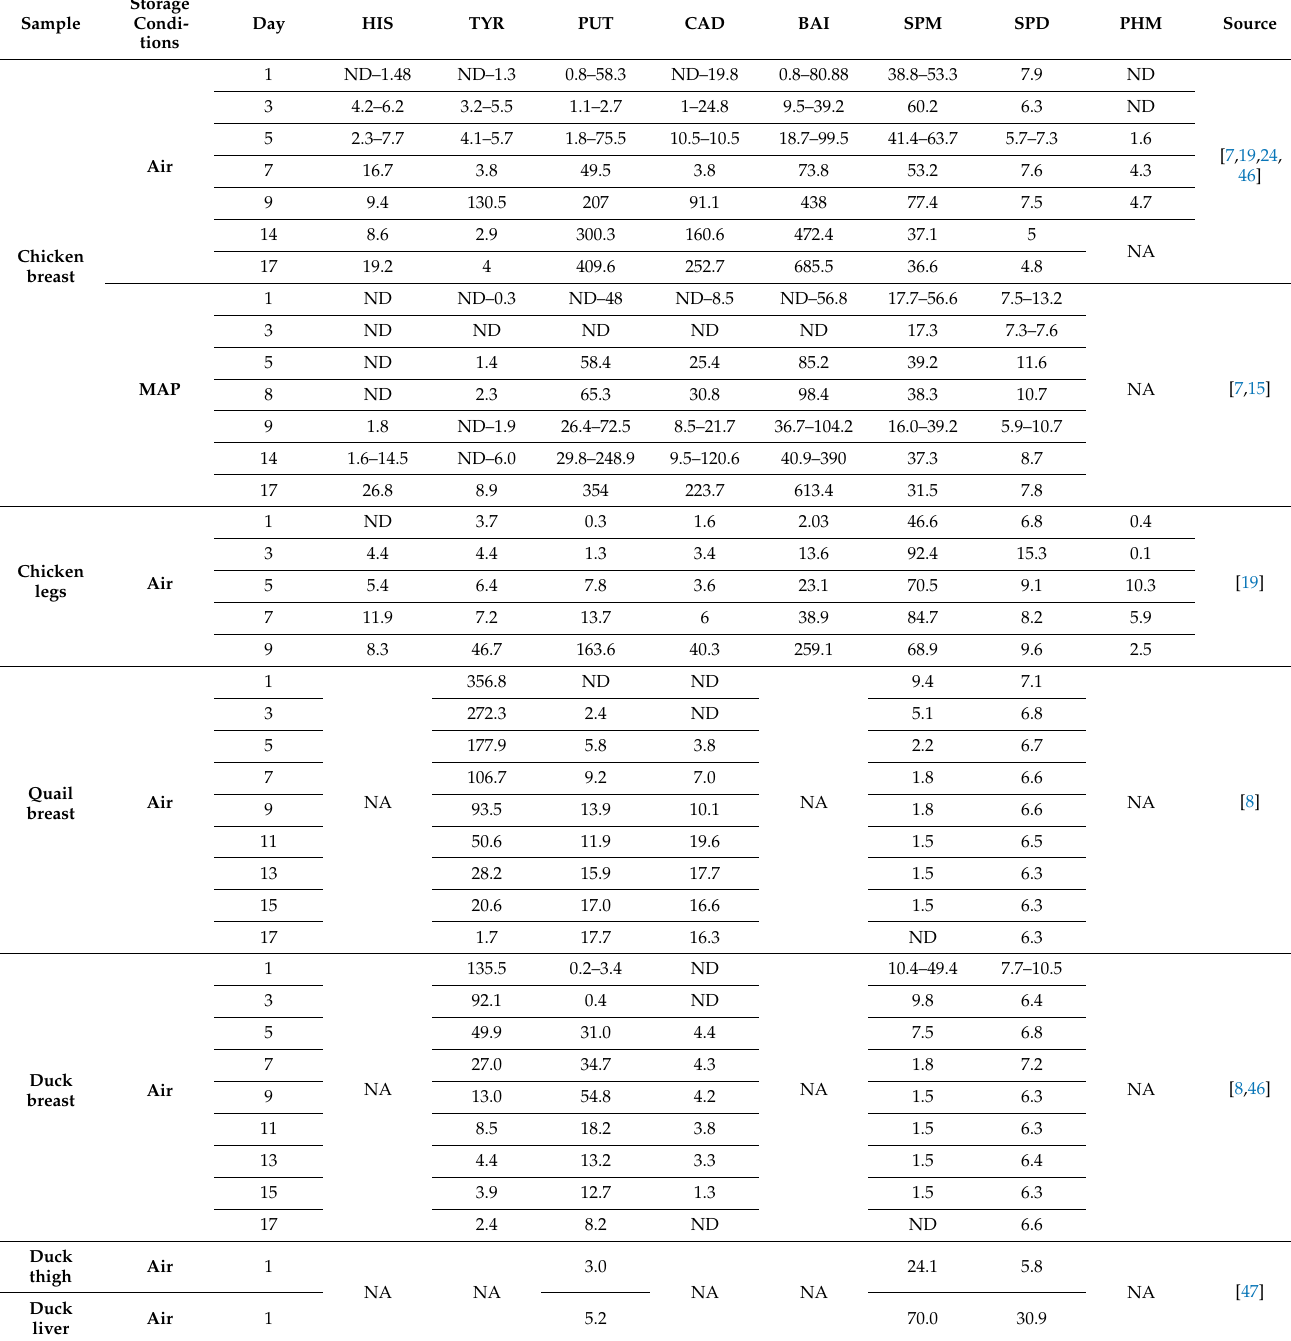
Table 2. Contents of biogenic amines (HIS: histamine, TYR: tyramine, PUT: putrescine, CAD: cadav- erine, BAI: biogenic amine index, SPM: spermine, SPD: spermidine, and PHM: β -phenylethylamine) in chicken meat during storage under different storage conditions